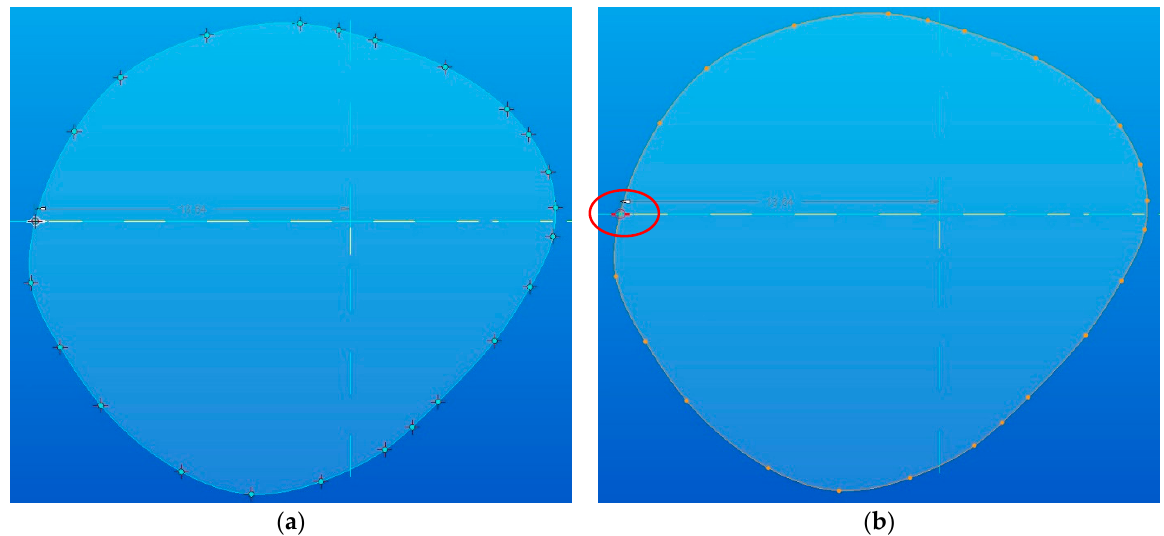
Figure 7. Tracing start/end points in each section: ( a ) the checkpoints of the sketches; ( b ) starting point of the sketches.